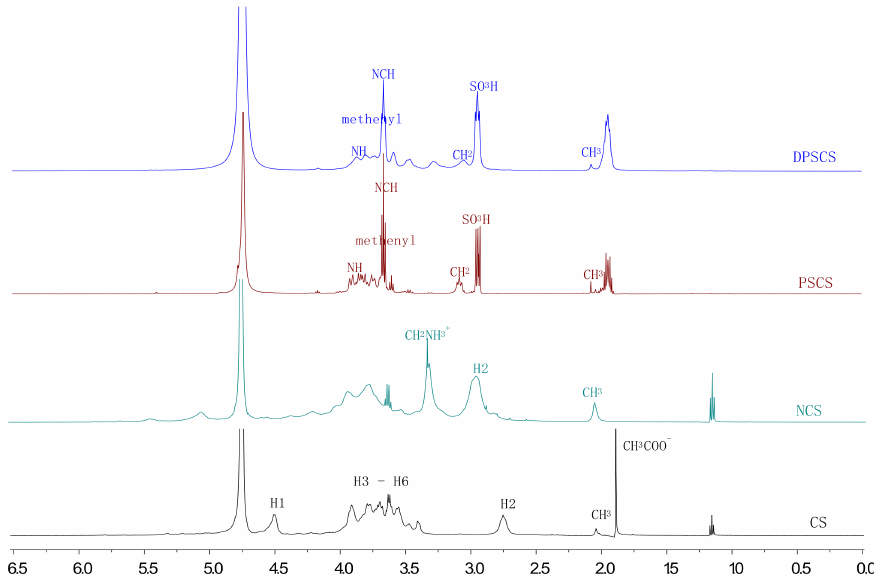
Figure 2. 1 H NMR spectra of chitosan derivatives.